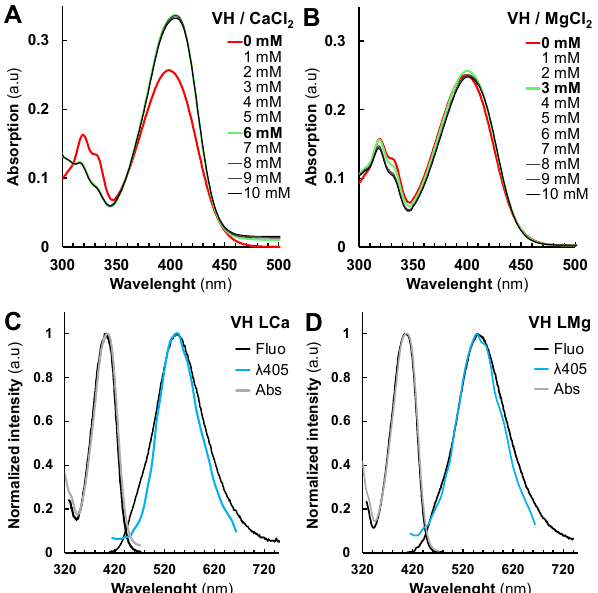
Figure 3. Vismione H VH photophysical properties are influenced by metal cations complexation. ( A , B ) Absorption spectra of metal complexes formed by VH with different amount of Ca (II) ( A ) and ( B ) Mg (II) spectra with no complex formed (bold red) and with the highest changes in the absorption spectrum (bold green). Normalized fluorescence (black), absorption (grey) and SImaging spectra of VH-Ca ( C ) and ( D ) VH-Mg complexes at λ 405